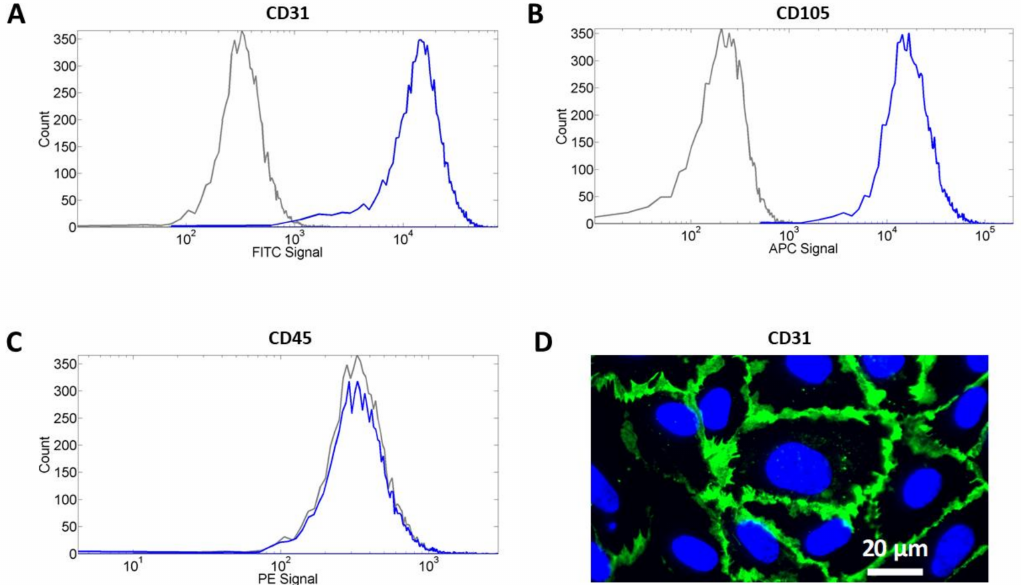
Figure 1. Characterization of human cord blood-derived endothelial cells (hCB-EC) monolayers using flow cytometry and immunocytochemistry. ( A – C ) Flow cytometry results show that hCB-ECs are positive for endothelial cell markers CD31 and CD105 while negative for CD45, a hematopoietic marker. ( D ) Immunocytochemistry of CD31 shows that the expression of CD31 is detected on the cell membrane (green—CD31; blue—nuclei). Scale bar = 20 µ